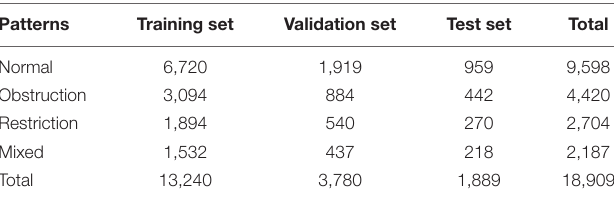
TABLE 1 | The distribution of datasets to develop deep learning